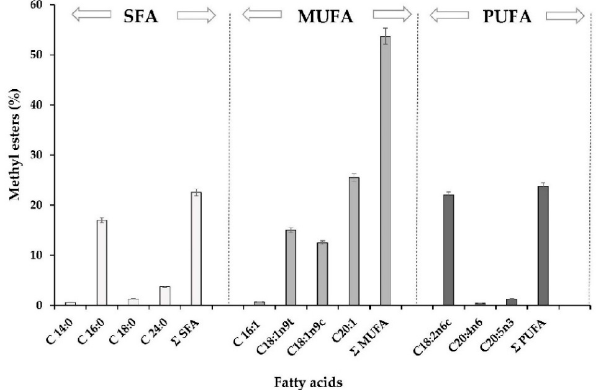
Figure 1. Fatty acid composition of the oleoresin extracted by SC-CO 2 from the microalga Haematococcus pluvialis determined by GC-FID. SFA: saturated fatty acids, MFA: monounsaturated fatty acids, and PFA: polyunsaturated fatty acids. All data are measured as the percentage of total fatty acid methyl esters (% area; n = 3; ±